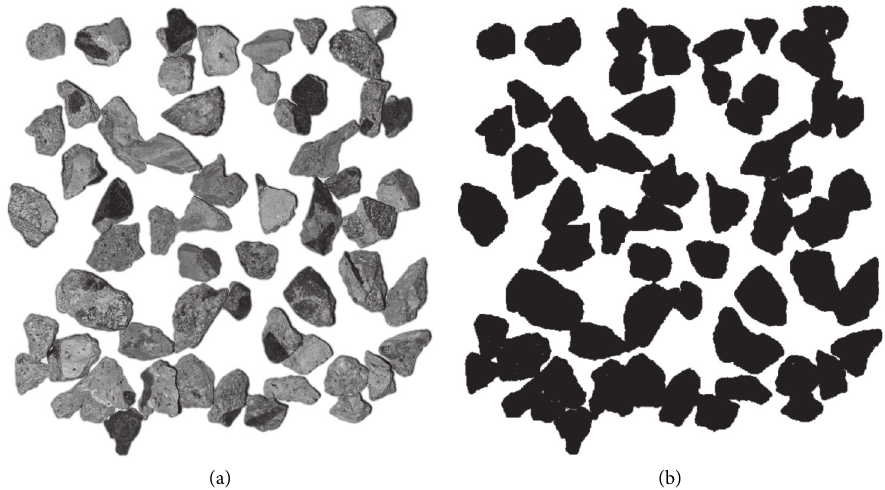
Figure 7: (a) Grayscale. (b) Recognition effect.